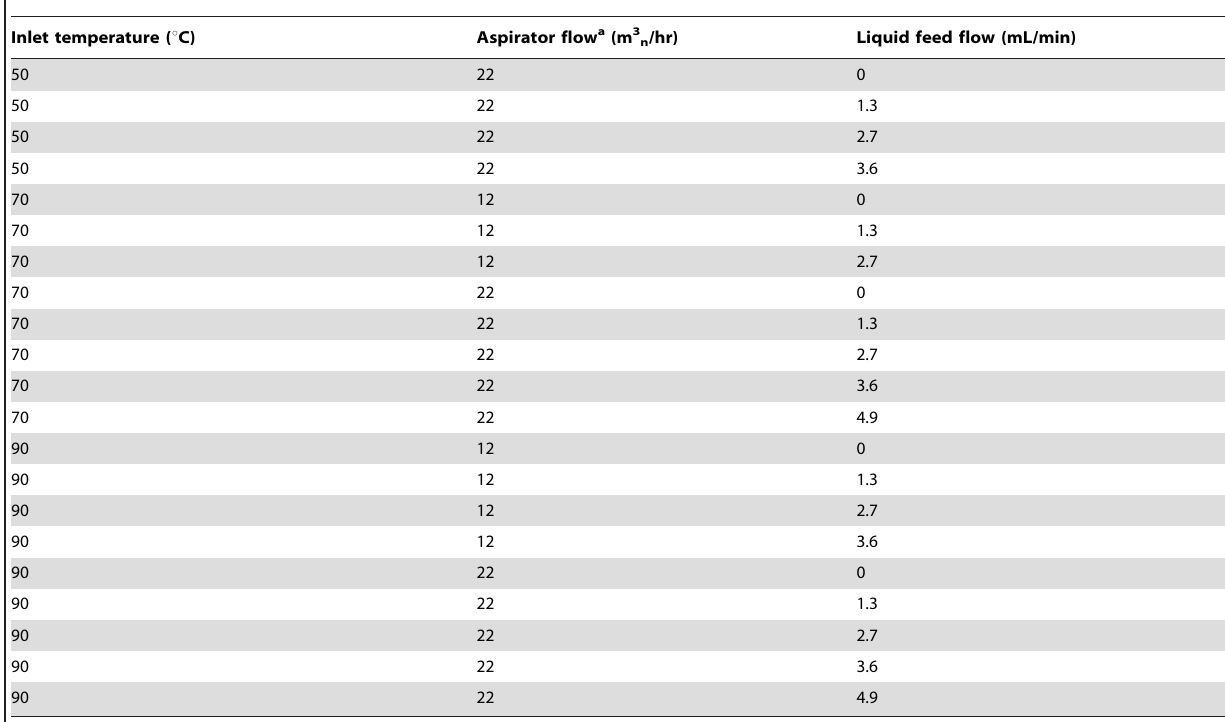
Table 2. Spray dryer settings used for relative humidity measurements.